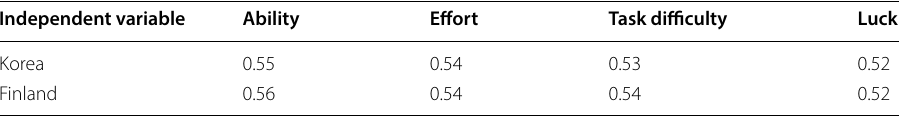
Table 4 McFadden’s R 2 for each ordinal regression model Independent